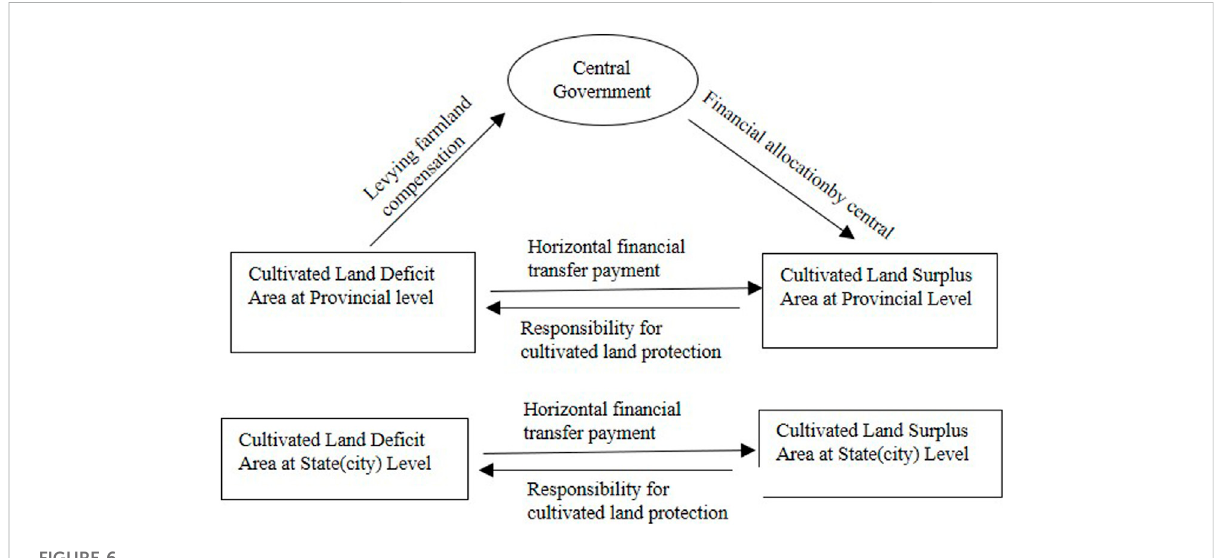
FIGURE 6 Establishing a compensation method combining various